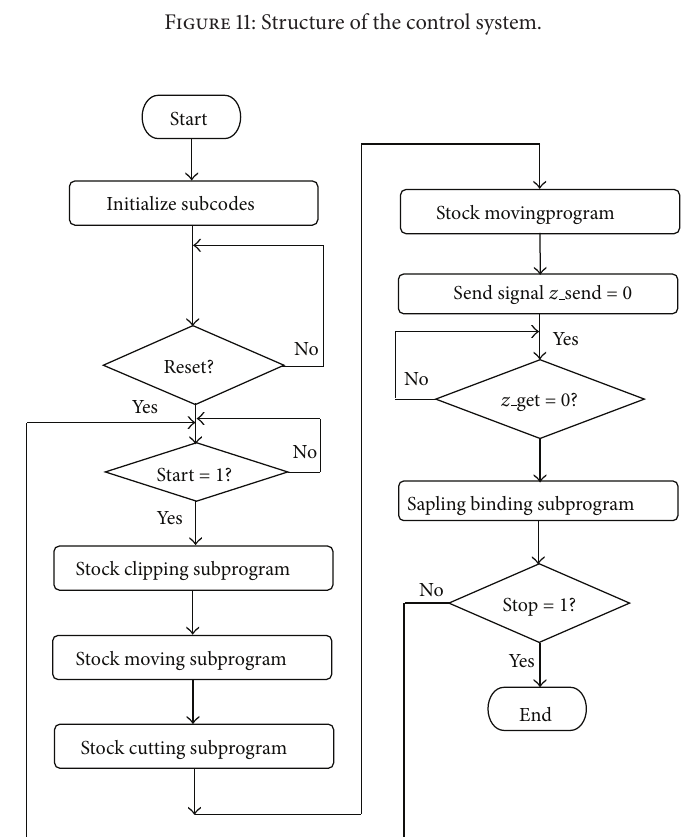
Figure 12: Flow diagram of stock processing main control module.